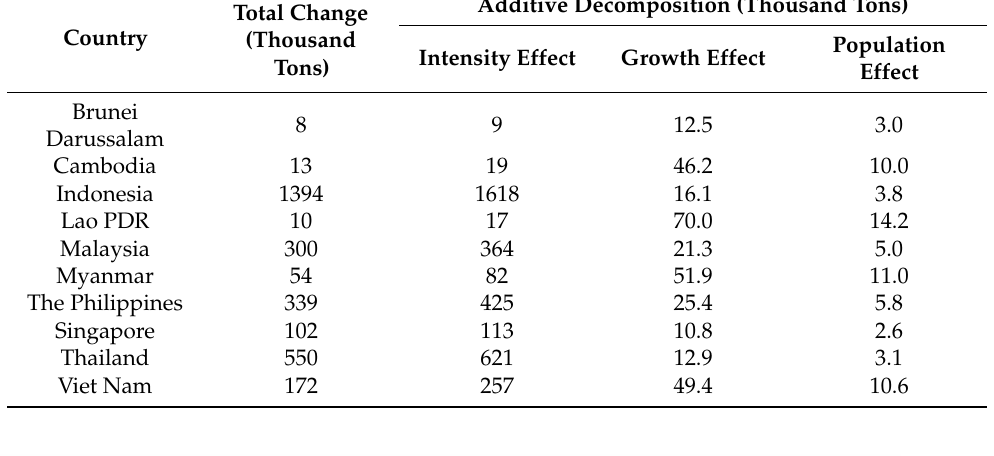
Table 2. LMDI decomposition result: Additive decomposition from 2015 to 2019.